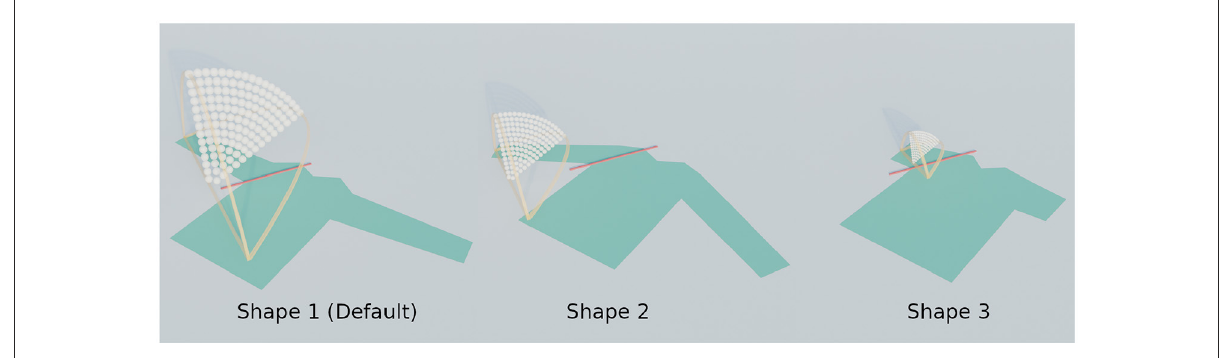
FIGURE6 The three examined shapes. Note how the shape of the cloth affects the distance between the start and end points of the fold, and therefore also the spatial size of the search range.